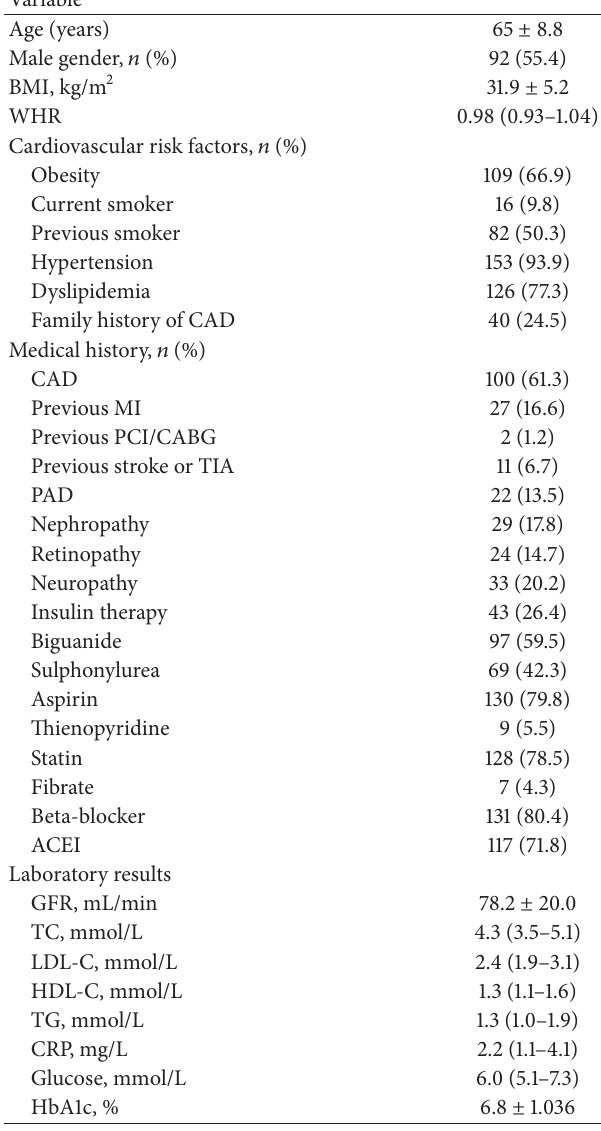
Table 1: Patient characteristics ( 𝑛 = 163